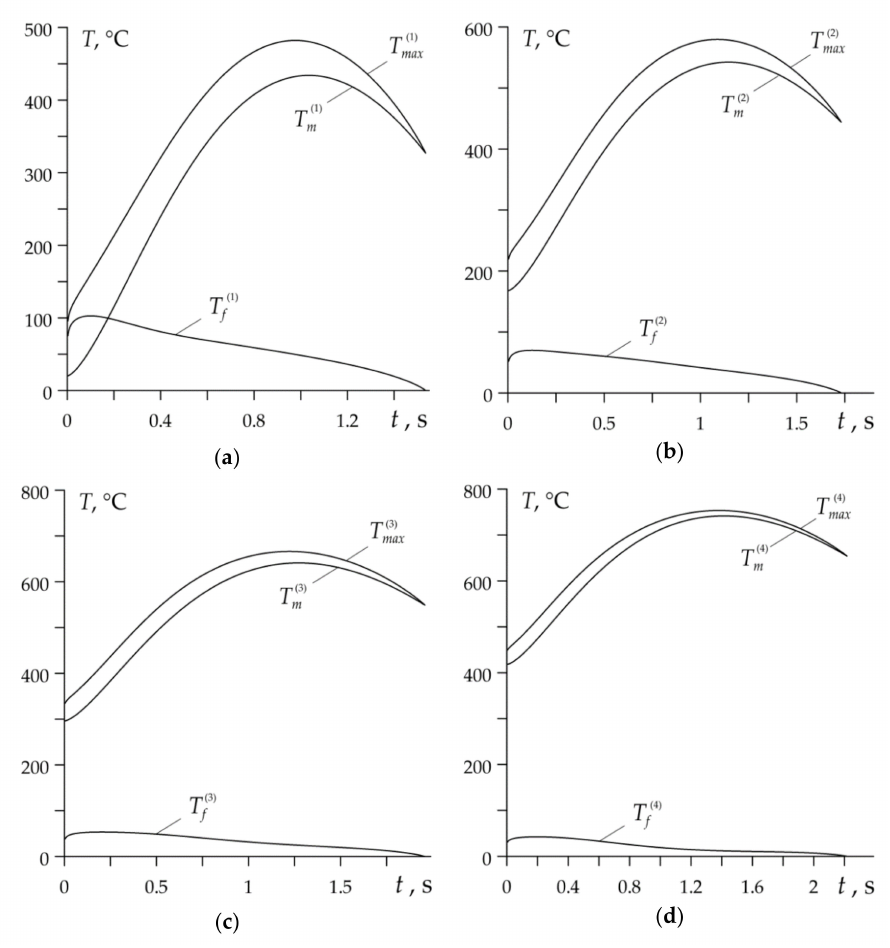
( k ) ( k ) ( k ) and maximum T m , flash T max temperatures for disc brake f